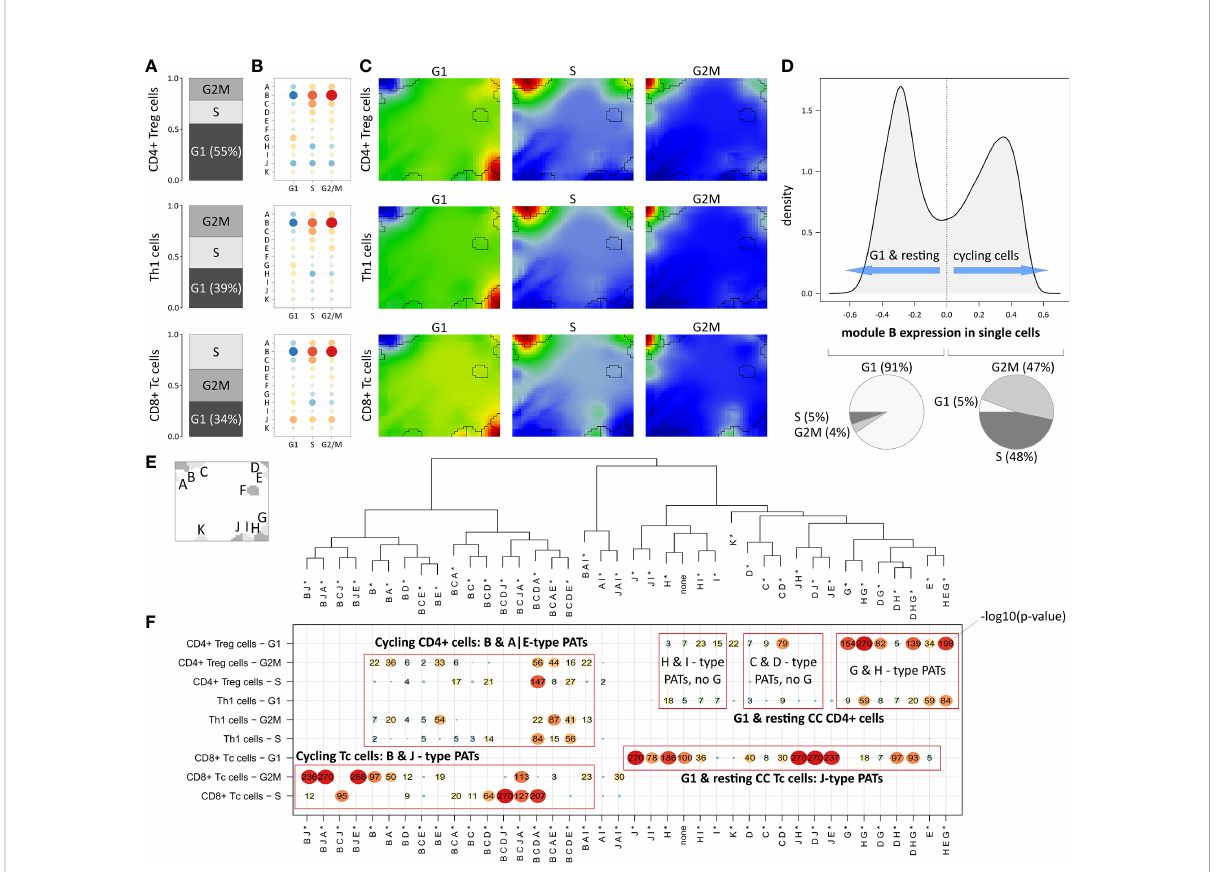
FIGURE 4 Segregation of Treg, Th1 and Tc subpopulations according to cell cycle phase: (A) Relative amounts of cells in G1, G2M and S phase, respectively. (B) Module expression grouped by subpopulations and cell cycle phase. Blue dots represent under-expressed modules, red dots over-expressed ones. (C) Corresponding expression portraits. (D) Distribution of module B expression in all cells shows bimodal character according to resting (G1-phase) and cycling (S- & G2M-phase) cells, respectively. (E) Module localizations in the map and hierarchical clustering of the PATs. * denotes that the PATs are not yet split into major and minor PATs. (F) The overview heatmap shows combinations of activated modules (PATs; major and minor PATs are summarized in this plot). Rows represent the subpopulations and cell cycle phases, columns represent the PATs clustered according to similarity of their average module expression. The numbers in the map show – log10 p-values derived from Fisher ’ s exact test. CD8+ cells show activation of module J related to LAG3-mediated T cell exhaustion partly together with cell cycle module